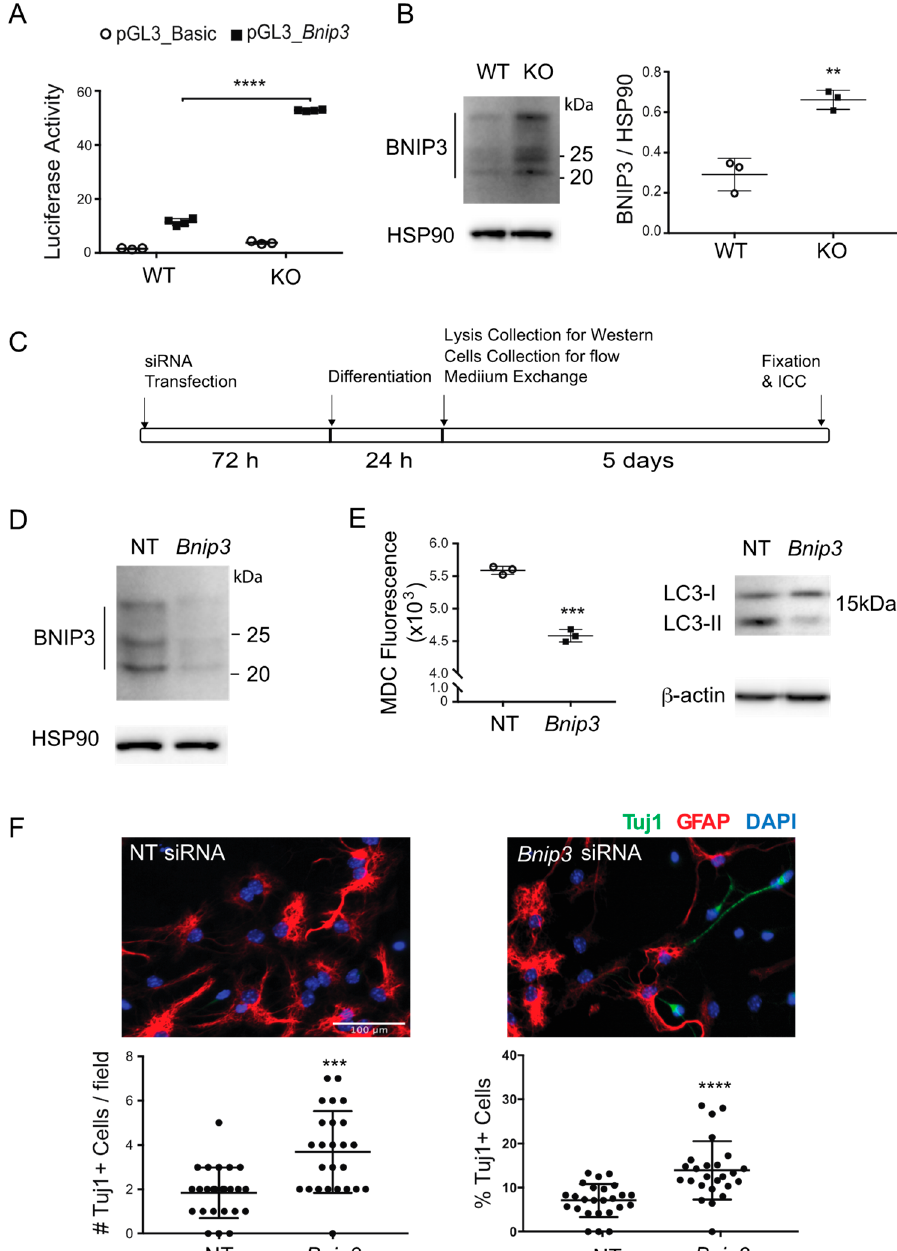
Figure 5. BNIP3 induces autophagy and represses neurogenesis in Mkp-1 KO NSCs. ( A ) Relative activity of pGL3_Bnip3 vs. control pGL3_Basic reporter constructs in differentiated (24 h) WT and Mkp-1 KO NSCs ( n = 4, two-way ANOVA, **** p < 0.0001). ( B ) Protein blotting for BNIP3 expression in the cytoplasmic fraction of NSCs 24 h post-differentiation (Left) and the quantification by densitometry relative to the loading control HSP90 (right) ( n = 3, t -test, ** p < 0.01). ( C ) Experimental timeline for Bnip3 knockdown illustrating sequential siRNA treatment, differentiation, and various endpoint analyses. ( D ) Confirmation of BNIP3 knockdown in Mkp-1 KO cells 24 h post-differentiation by protein blotting (NT, non-targeting siRNA transfection; Bnip3, mouse Bnip3 siRNA transfection). ( E ) Changes of MDC and LC3II levels in Mkp-1 KO NSC-D with Bnip3 siRNA transfection using flow cytometry and immunoblotting, respectively, 24 h after differentiation ( n = 3, t -test, *** p < 0.001). ( F ) Absolute number (#) per field and fraction (%) of Tuj1+ neurons (green) relative to total cell # following Bnip3 siRNA transfection in Mkp-1 KO NSC-D on day 6 post differentiation ( n = 25, t -test, *** p < 0.001, **** p < 0.0001).